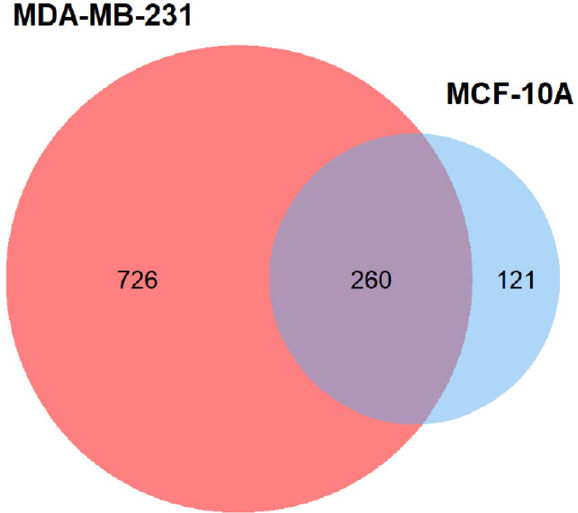
Figure 2. The overlap between MDA-MB-231 and MCF-10A exosomal proteomes. Out of the 986 MDA-MB-231 and the 399 MCF-10A exosomal proteins, 260 proteins were identified in both cell